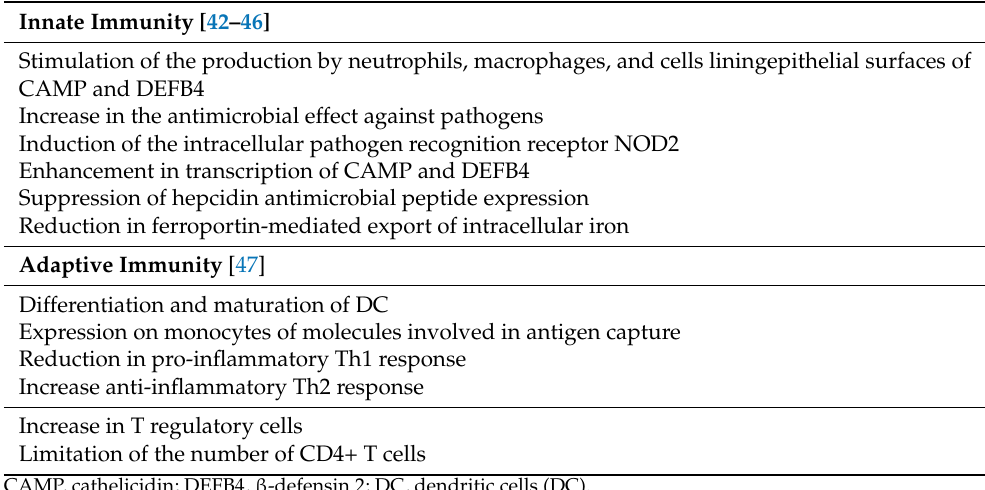
Figure 1. How vitamin D interacts with cells of the innate immunity. Table 2 summarizes immunomodulating activity of VD on immune systems. Table 2. Immunomodulating activity of vitamin D on immune